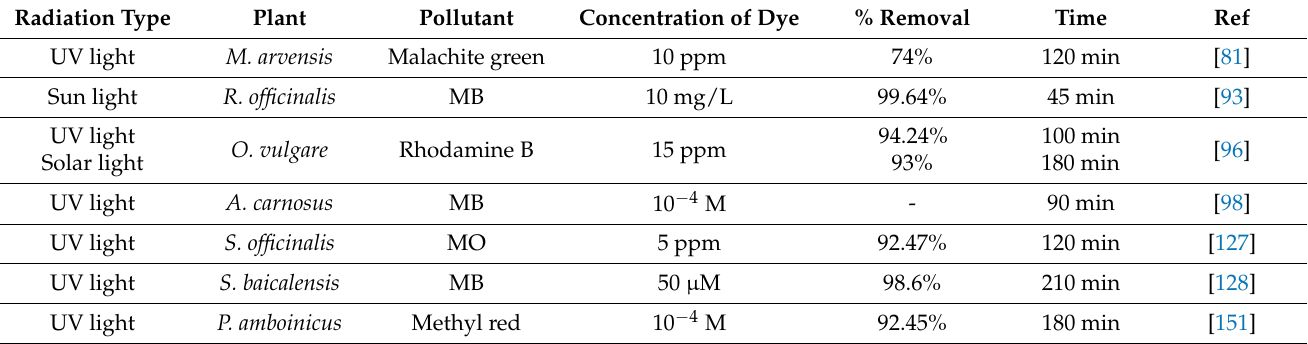
Table 3. The percentage removal of organic dyes using some Lamiaceae-mediated ZnO